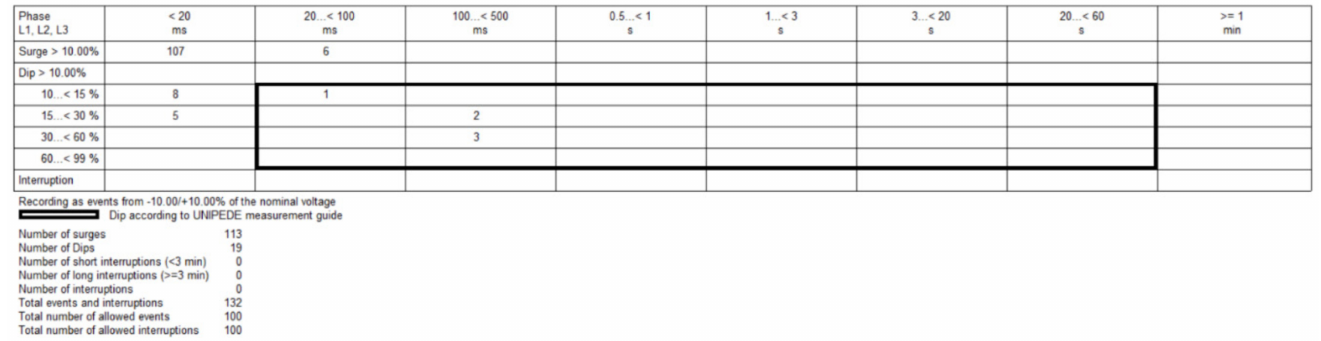
Figure 12. Recorded surges and dips at point B (phases L1, L2, L3).